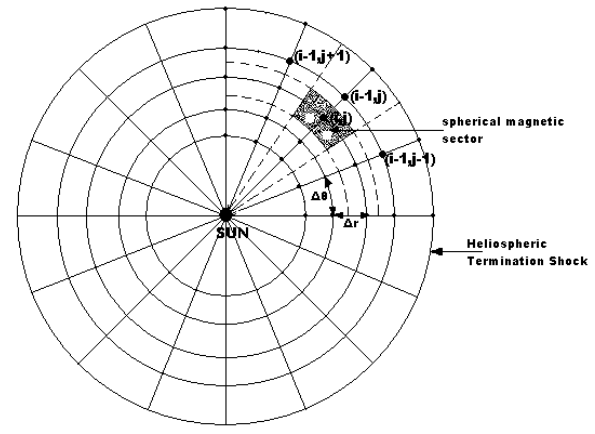
Fig. 1. Applied Heliospheric grid for the study of CR latitudinal variations. Definition of the “spherical magnetic